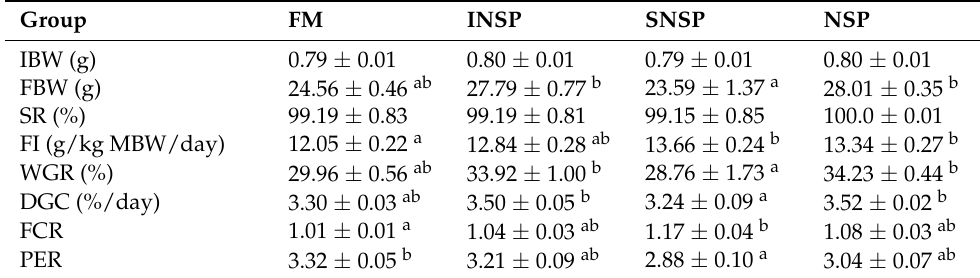
Table 2. Growth results of grass carp fed by test feeds.